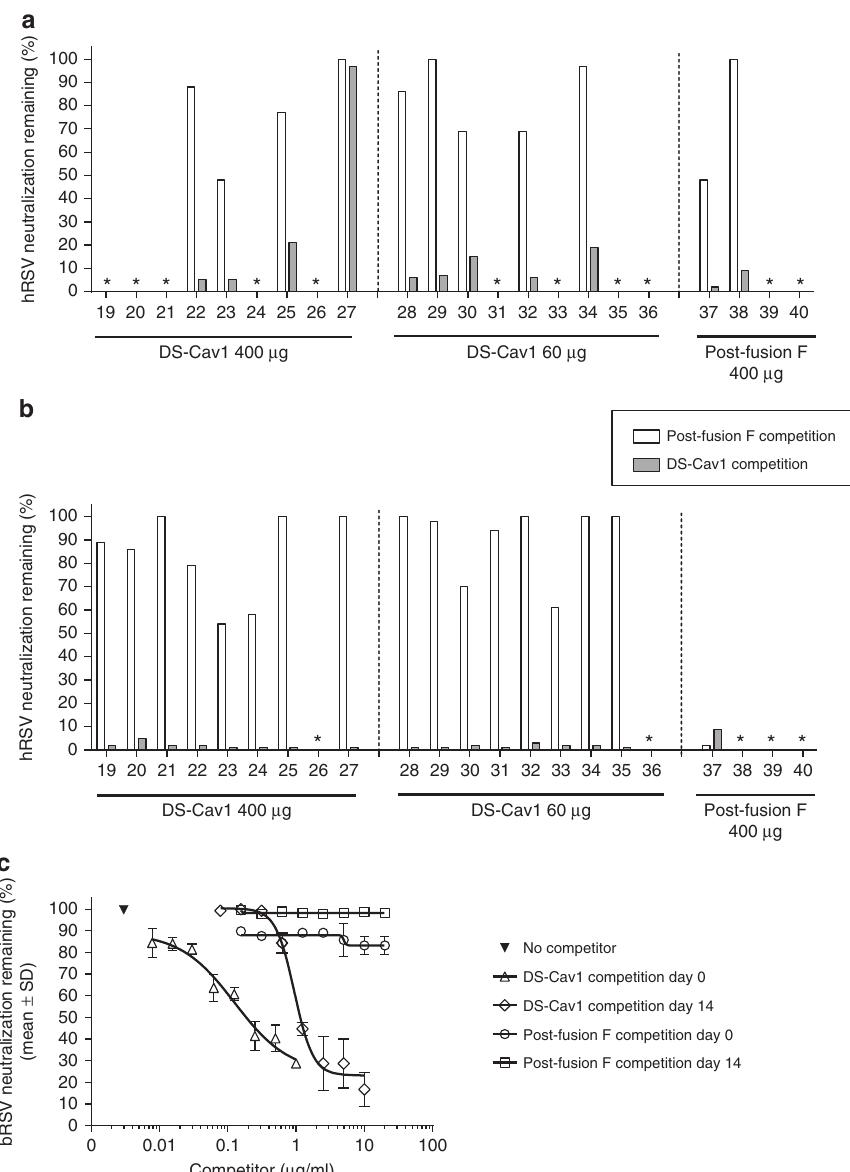
Fig. 4 Remaining neutralization activity after serum pre-incubation with pre-F DS-Cav1 or post-fusion F. Day 0 ( a ) and Day 14 ( b ) individual serum samples from each of the treatment groups with neutralization titers > 100 were pre-incubated with either DS-Cav1 or post-fusion F (40 µ g/ml), their hRSV neutralization titers were determined and the % remaining neutralization activity was calculated relative to neutralization titers without protein pre- incubation. Asterisks indicate animals for which neutralization titers were ≤ 100. c Day 0 or Day 14 serum pools from each of the treatment groups were pre-incubated with varying concentrations of DS-Cav1 or post-fusion F (competitor) and the % remaining bRSV neutralization activity was calculated as described above. Symbols indicate the mean and error bars the SD of duplicate